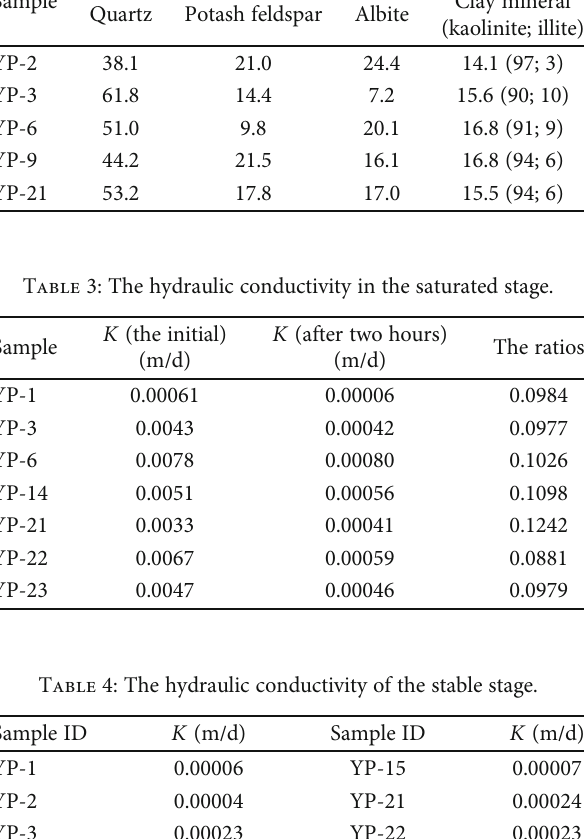
Table 2: X-ray di ff raction quantitative analysis for whole sandstone. Sample